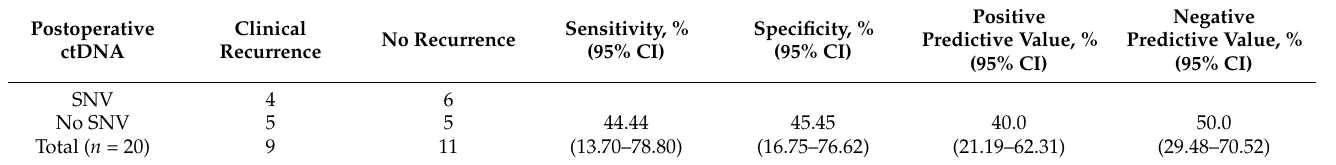
Table 2. Diagnostic value of SNV of ctDNA by targeted sequencing prediction of clinical